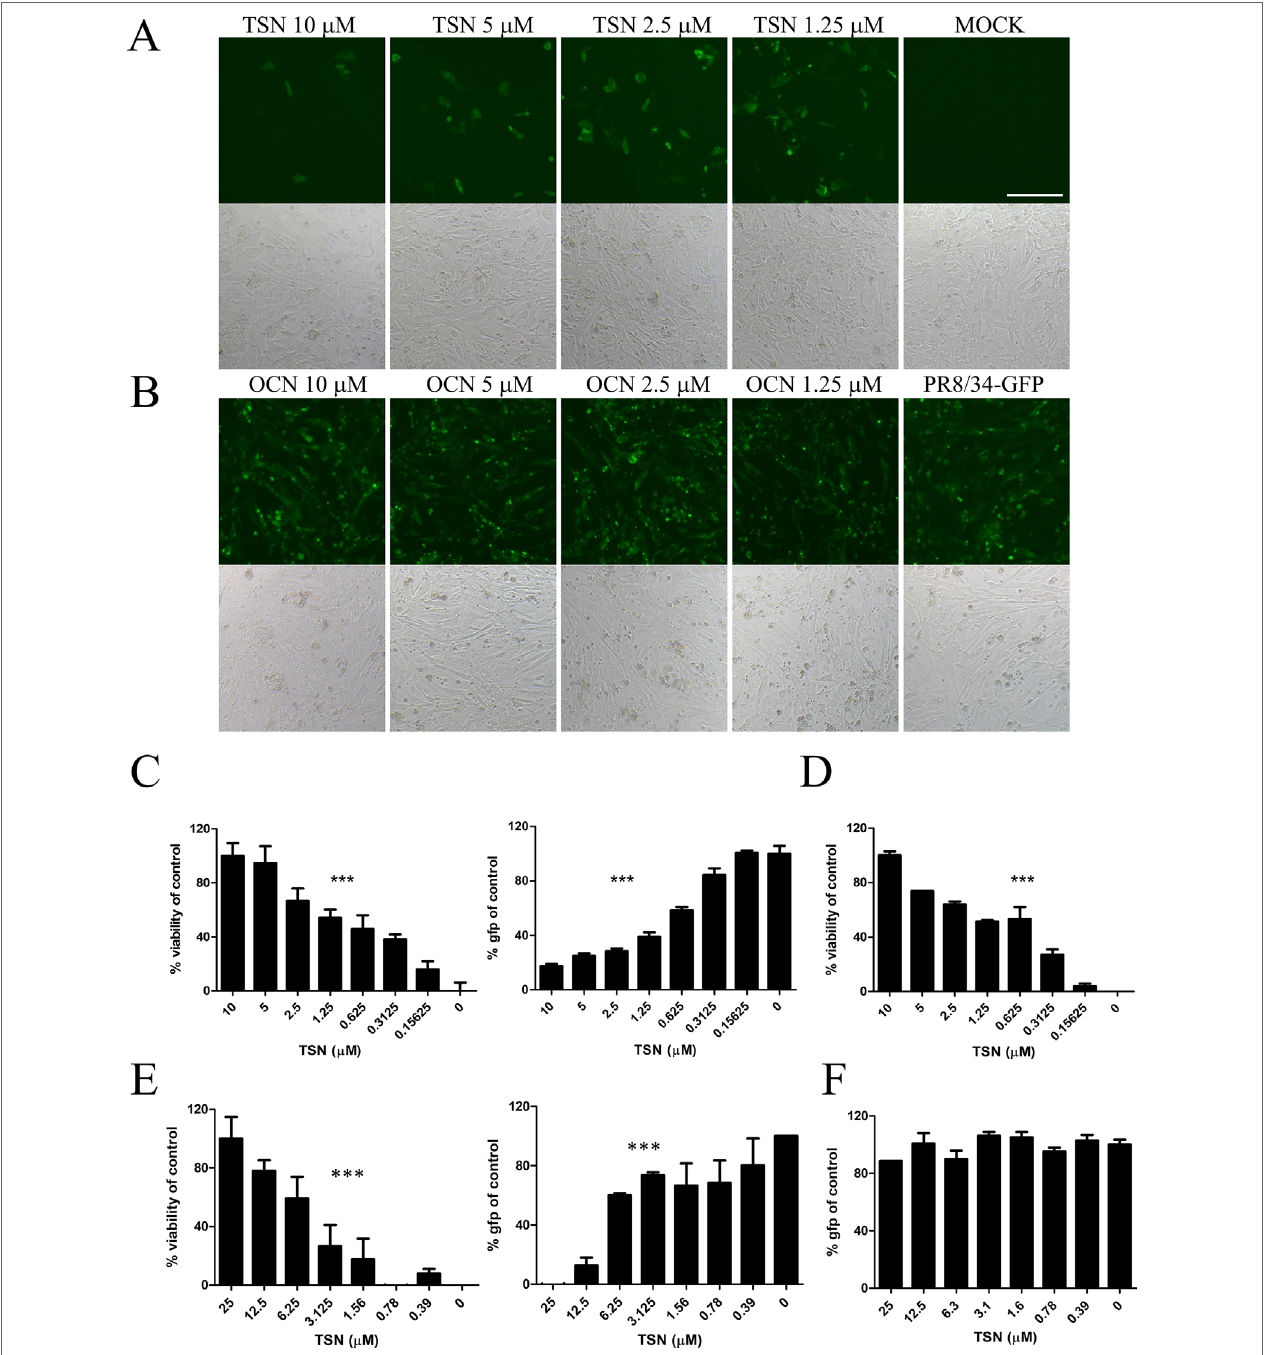
FIGURE 3 | TSN suppressed influenza A virus infection in a dose-dependent manner. (A and B) In the pretreatment assay, MDCK cells were pretreated with various concentrations of TSN (A) or OCN (B) for 6 h prior to 10 MOI A/PR/8/34-GFP virus infection. The expression of viral GFP protein was detected by fluorescence microscopy (upper panel, fluorescence; bottom panel, phase contrast) at 24 h postinfection (hpi). Scale bars, 100 µm at ×20 magnification. (C) Measurement of the cytopathic effect (CPE) induced by 10 MOI A/PR/8/34-GFP virus in MDCKs cells pretreated with TSN using the MTS assay (left panel, IC 50 = 0.76 microM) (non- virus-infected cell, 100% viability), and the expression of viral GFP was detected by fluorescence spectrometry (right panel, IC 50 = 0.55 microM) at 24 hpi (GFP-virus- infected cell, 100% GFP value). (D) H3N2 (10 MOI) virus-induced CPE in TSN-pretreated MDCK cells was measured by MTS assay at 24 hpi. (IC 50 = 0.48 microM) (E) In the cotreatment assay, MDCK cells were treated with a mixture of 10 MOI A/PR/8/34-GFP virus and TSN. CPE was measured by MTS assay (left panel, IC 50 = 5.09 microM) and the expression of viral GFP protein by fluorescence spectrometry (right panel, IC 50 = 3.34 mM) at 24 hpi. (F) In the posttreatment assay, MDCK cells were treated with TSN after 10 MOI A/PR/8/34-GFP infection, and CPE was measured by MTS assay at 24 hpi. The data are presented as mean ± SD of three replicates. All data are representative of three independent experiments. The statistical significance was analyzed by one-way ANOVA. *** P <